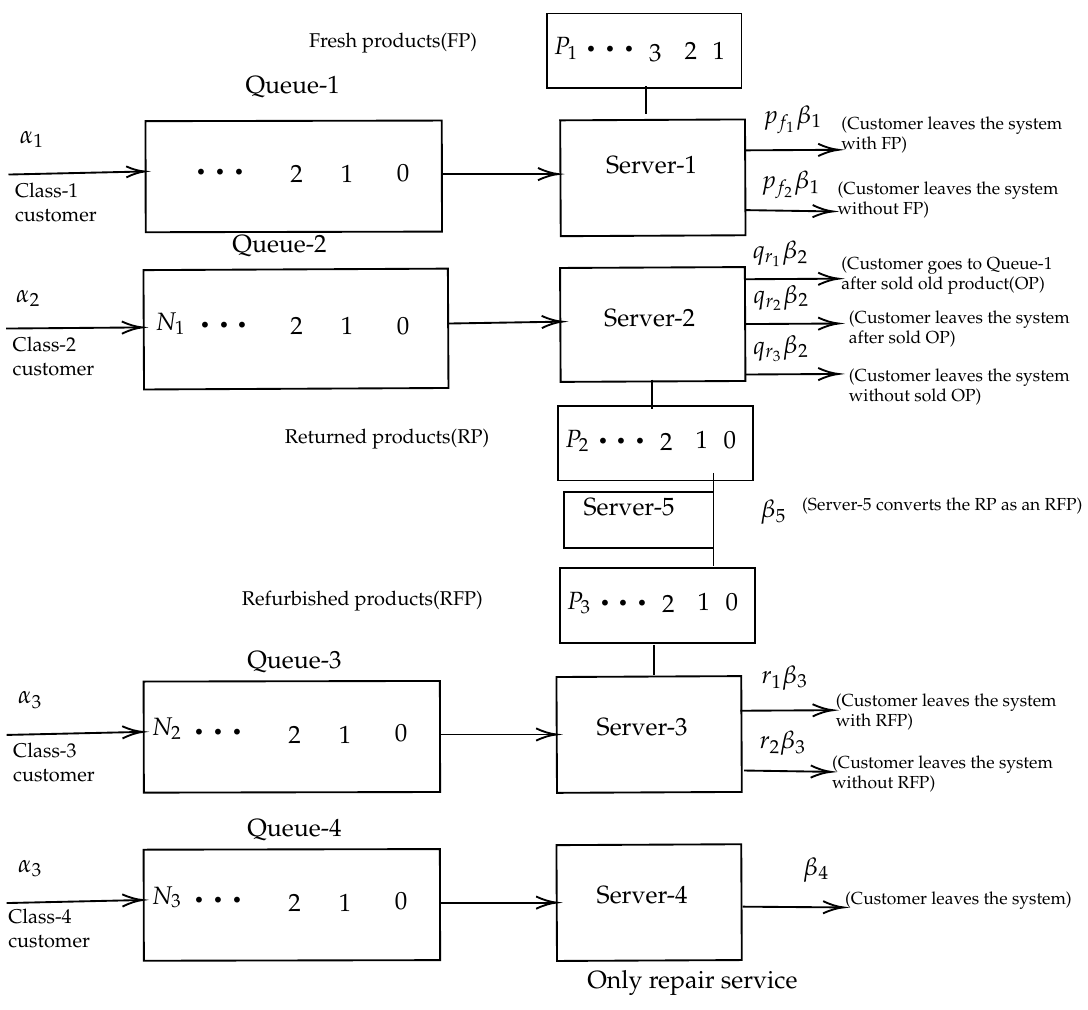
Figure 2. Pictorial representation of the